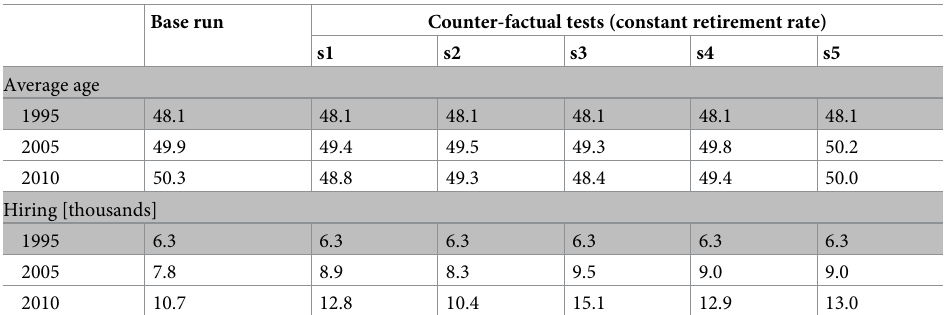
Table 2. Simulation results. Base